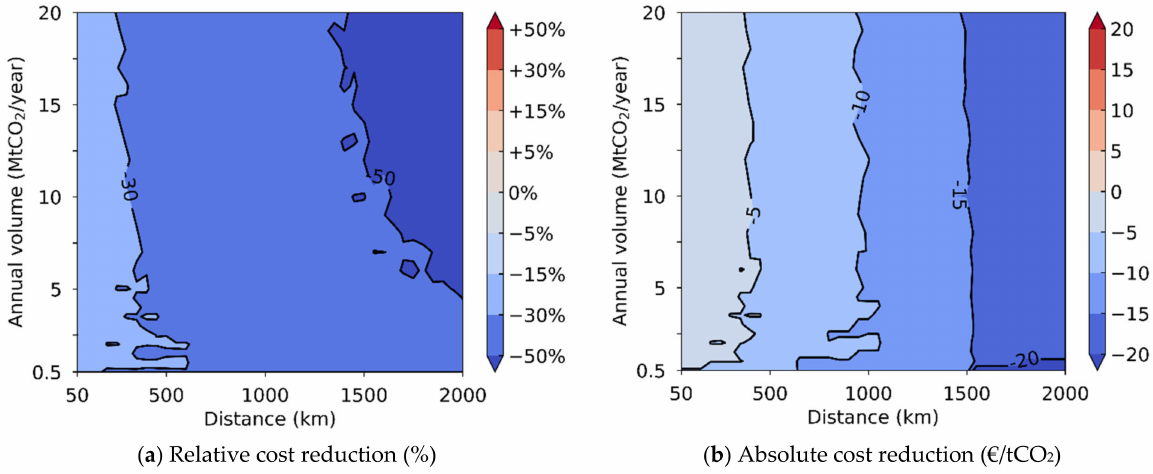
Figure 6. Cost comparison maps showing the cost reductions enabled by the 7 barg shipping option compared to the 15 barg one in Table 2, considering that the CO 2 entering the liquefaction process is at 90 barg